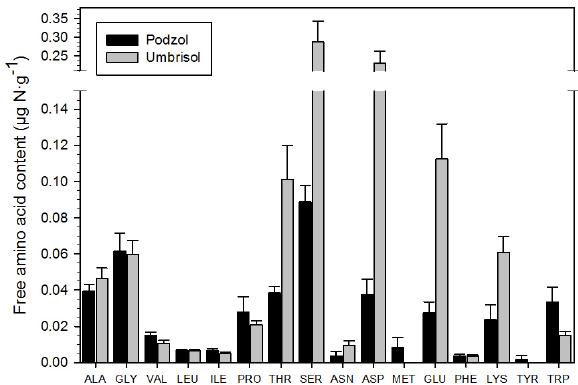
Figure 4. Initial soil content of individual amino acids (µgN– FAAg − 1 DW soil) indicated as average ± SE (standard error) ( n =